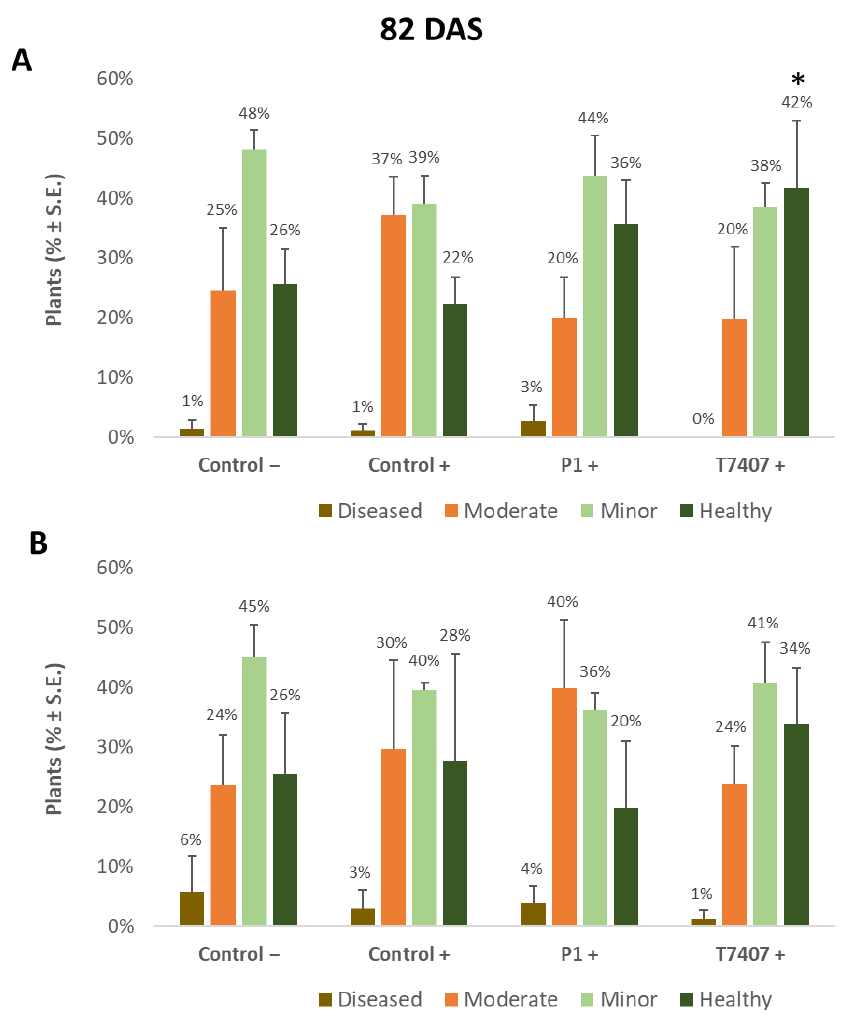
Figure 4. Quantitative evaluation of lower stem disease symptoms at the end of the 2020 field experiment (82 DAS, 33 days after fertilization, DAF). ( A ). Stabbing-free treatments. ( B ). Stabbing inoculation treatments. Categories are described in Figure 2. The experimental treatments and controls are depicted in Figure 3. Values are calculated based on 61–158 plants in each treatment in at least two repeats. Deviation bars represent standard error. No statistical difference between the treatments or the treatments and the controls could be identified using the one-way ANOVA test. Yet, a one-tailed t -test compared to the infected control (a more powerful test) revealed significant differences ( p < 0.05), indicated by an asterisk